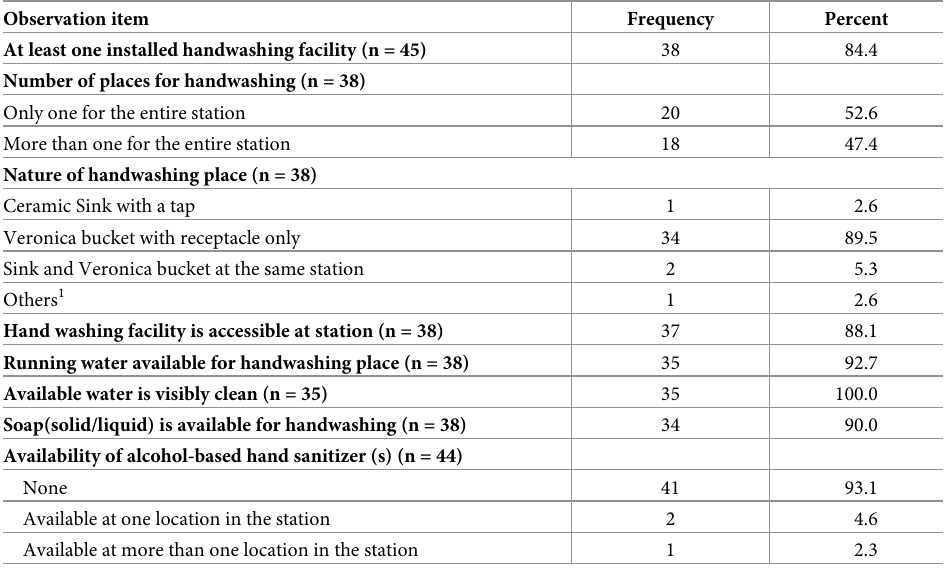
Table 3. Availability of hand hygiene amenities at transport stations in the Greater Accra Region.